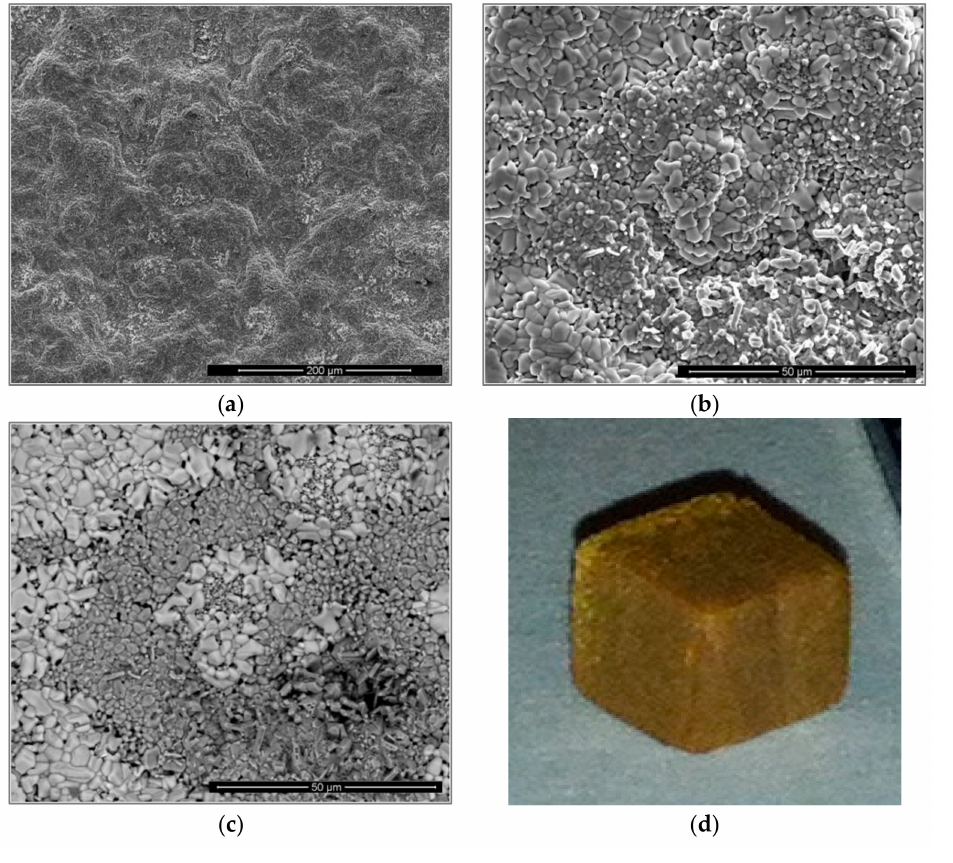
Figure 10. ( a – c ) Images of the surface of the scale formed on the alloy OHS1 after isothermal oxidation in air at 1200 ◦ C and ( d ) the oxidized specimen. ( a ) and ( b ) are SE images, and ( c ) is a BSE